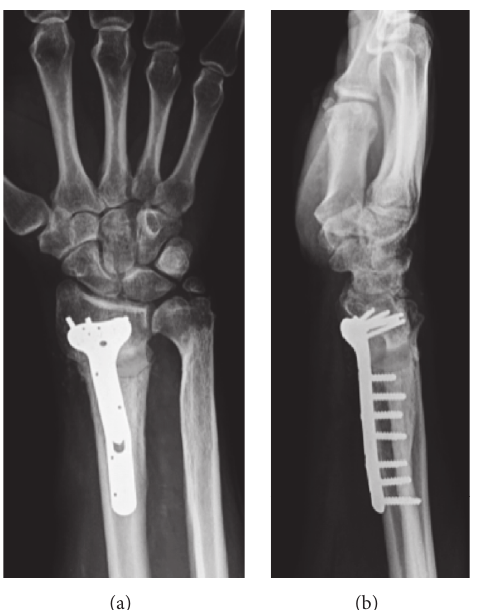
Figure 3: (a-b) Plain radiographs postoperative images at 8-month follow-up showed DR fixation with a longer stainless steel volar locking